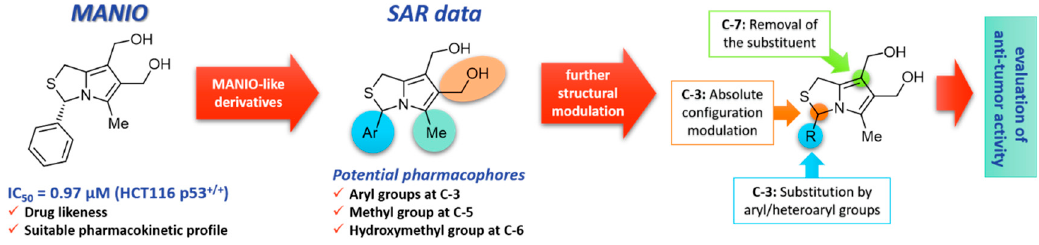
Figure 1. SAR-based structural modulation of Figure 37. SAR-based structural modulation of MANIO.